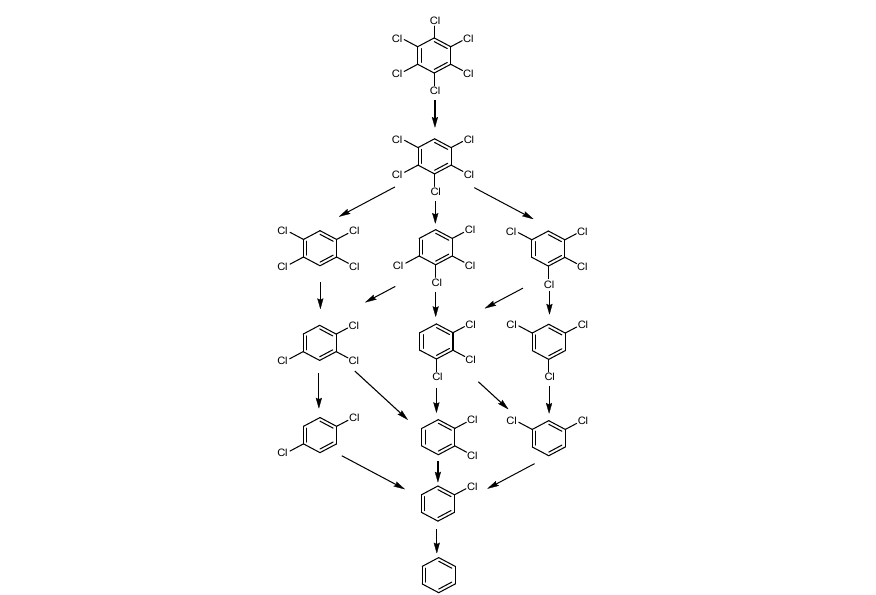
Figure 3. The proposed pathway of hexachlorobenzene and (poly)chlorinated benzenes HDC using studied Al alloys.